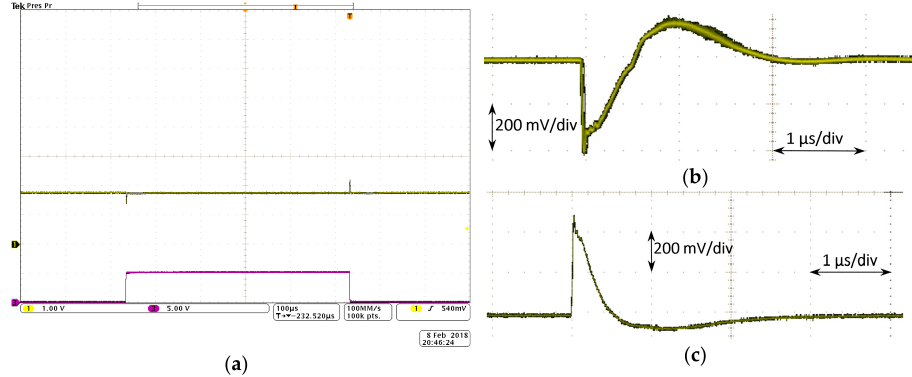
Figure 12. Load transient behavior: ( a ) with dynamic CBBC (green) output voltage and (purple) ON/OFF (50 mA/0 mA) of the switch that allows load current through; ( b ) US zoomed image; and ( c ) OS zoomed image.